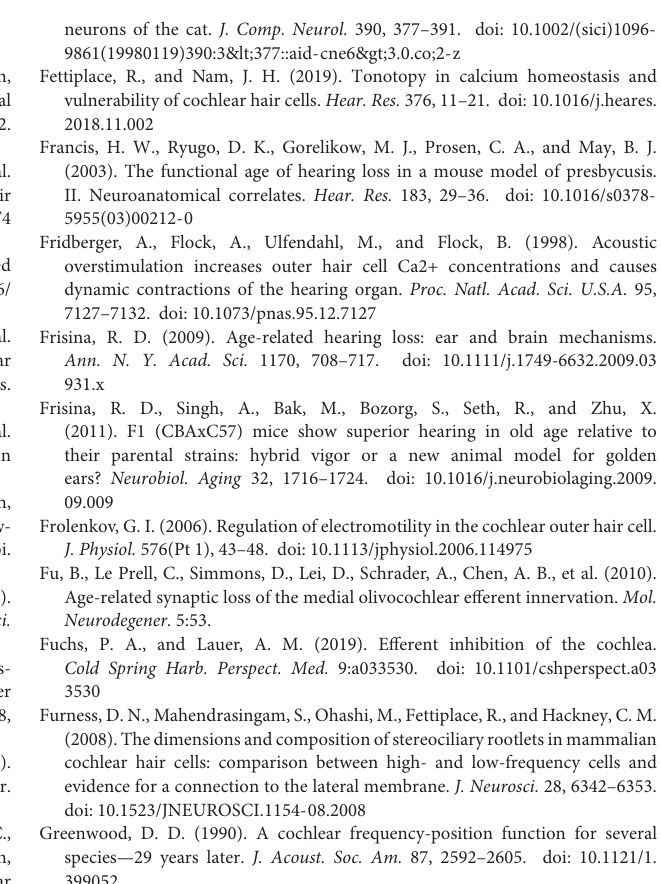
Supplementary Figure 1 | (A) 360 bp PCR product for 12 CBA Ocm KO animals (lanes 2-13) and 1 CBA/CaJ control (lane 14). The DNA ladder is shown in lane 1. (B) Chromatograph of sequencing results from lane 2 and lane 14 showing that neither KO nor control animals have the G- > A Cdh23 ahl mutation. (C,D) 5 mo old CBA wild type (WT) (C) and CBA Ocm KO (D) mid-modiolar sections stained with antibodies to Oncomodulin (OCM) (gray). Co-stained with phalloidin (green) and DAPI (magenta). Scale bar = 10 µ m. (E,F) Line profile of 1 mo old (E) and 20 mo old (F) CBA WT mid-modiolar section stained with antibodies to OCM (gray) and co-stained with DAPI (magenta). Supplementary Figure 2 | Cytoplasmic vs. nuclear OCM fluorescence during aging in WT (A) CBA and (B) C57 mice. (A) 8 and 32 kHz c/n ratios from region of interests (ROIs) at 1 – 2 mo, 12 mo, and 20-30 mo ( n = 5) CBA WT mice. (B) 8 kHz and 22 kHz c/n ratios from ROIs at 1 – 2 mo ( n = 2) and 5 – 7 mo ( n = 2) in C57 WT mice. Quantification of choline acetyltransferase (ChAT) labeled efferent clusters in the 5 – 8 kHz and 22 – 40 kHz regions of panels (C) C57 WT and (D) C57 KO. No statistical difference in ChAT clusters between any C57 WT regions. All WT regions were statistically significant ( p < 0.5) from basal region of 5 – 7 mo KO. (E) ChAT clusters from the 8 and 22 - 45 kHz regions of WT CBA mice at 1 – 2 mo, 12 mo ( n = 2) and 28 mo ( n = 2). 3 cochlea per condition unless otherwise indicated. All asterisks indicate p <